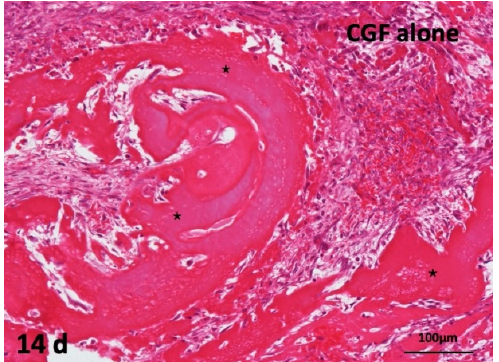
Figure 5. Histological images of CGF alone membrane on periosteum of skull. Acellular appearance inside CGF bundle ( ⋆ ) and cellular invasion into spaces between bundles (HE).